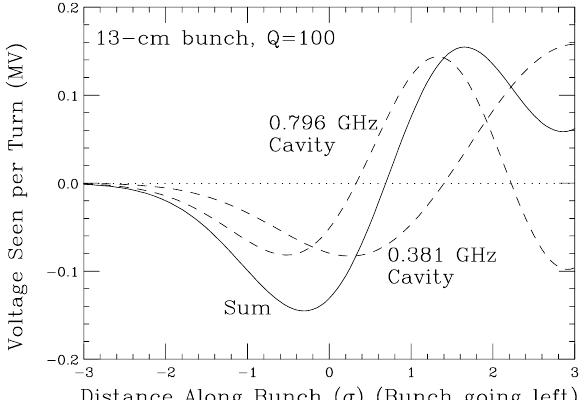
FIG. 10. Beamloading voltages seen by particles in the 13- cm bunch as they traverse the wake-potential compensating cavities. The particles are at a distance behind the bunch center in units of rms bunch length.